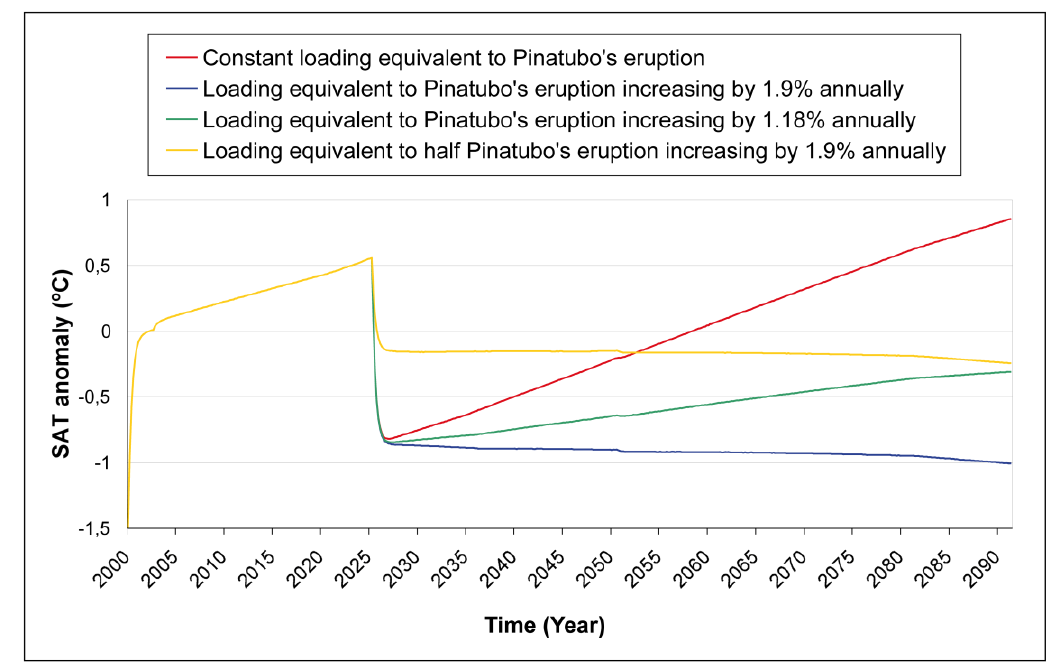
Figure 2. Comparison of different geoengineering intensities within the A1B